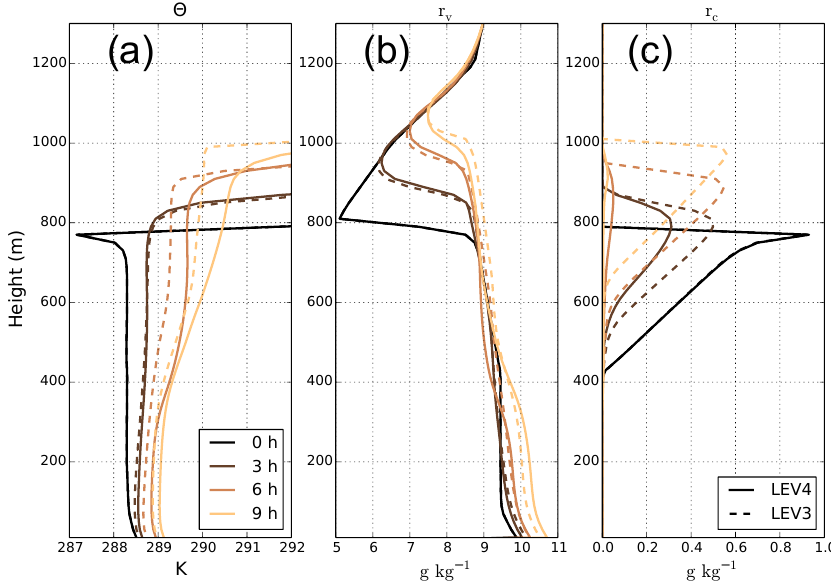
Figure 5. Domain mean vertical profiles of (a) potential temperature, (b) water-vapour mixing ratio and (c) liquid water mixing ratio. Data are plotted in 3h intervals from the initial state of the model to 9h into the simulation (from black to orange). Results from LEV3 are shown with a dashed line while those from LEV4 are shown with a solid